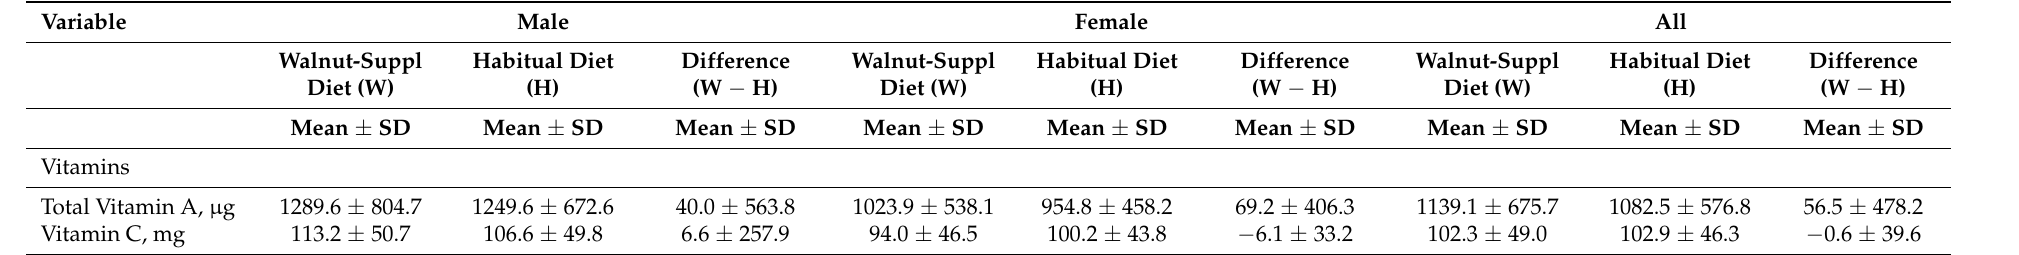
Table 3. Changes in the intake of specific micronutrients of 90 participants evaluated by seven 24 h recalls for each diet